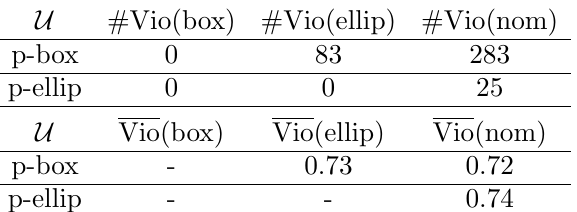
Table 6. Feasibility performance